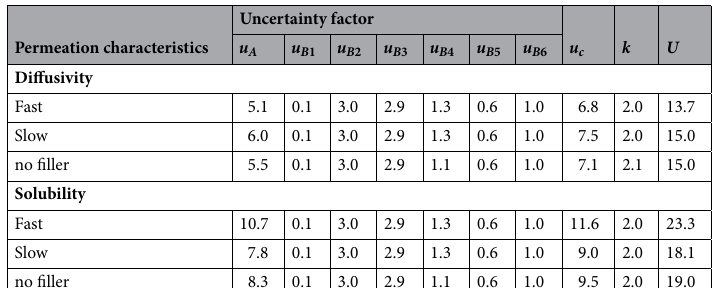
Table 2. Uncertainty budget [%] for the diffusivity and solubility of NBR (diameter: 4.4 mm, thickness: 2.3